Question: Compose a caption that would accompany this figure in a paper.
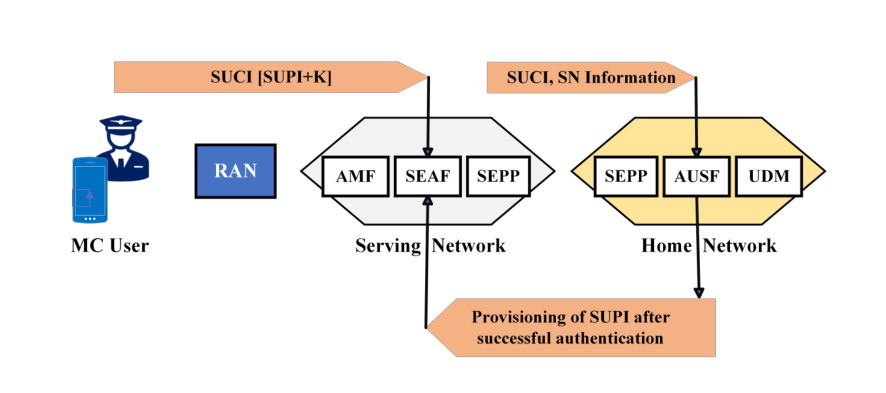
Answer: Authentication process during the 5G registration procedure